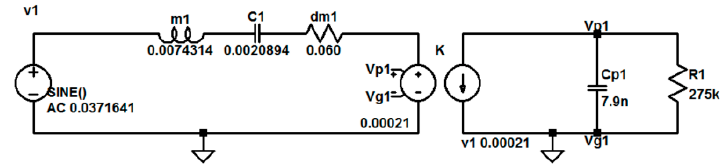
Figure 1. The lumped parameter model of a single piezoelectric cantilever (PEC) drawn in LTspice.